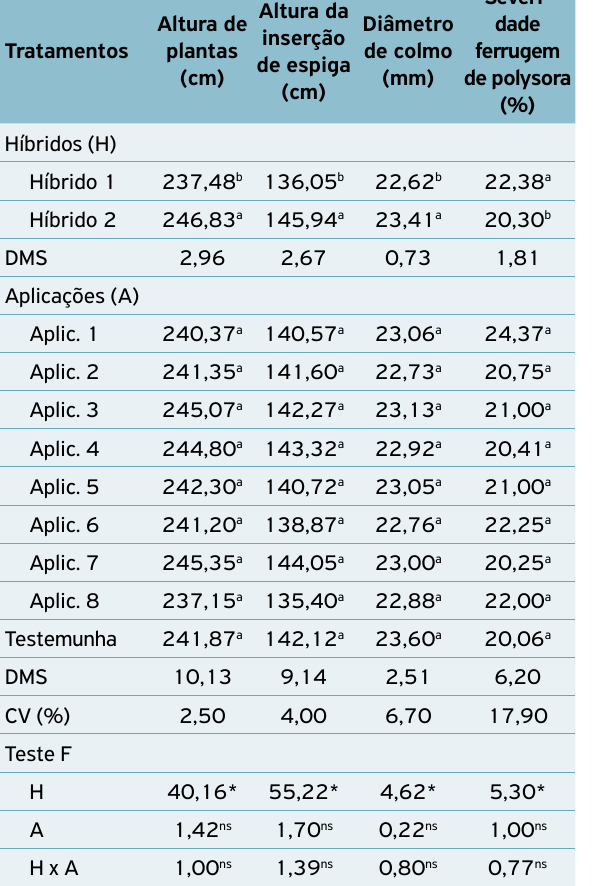
Tabela 3. Valores médios referentes à altura das plantas, altura da inserção de espiga, diâmetro de colmo e severidade de ferrugem de polysora para híbridos e aplicações de piraclostrobina. Jataí, Goiás, 2013/2014.